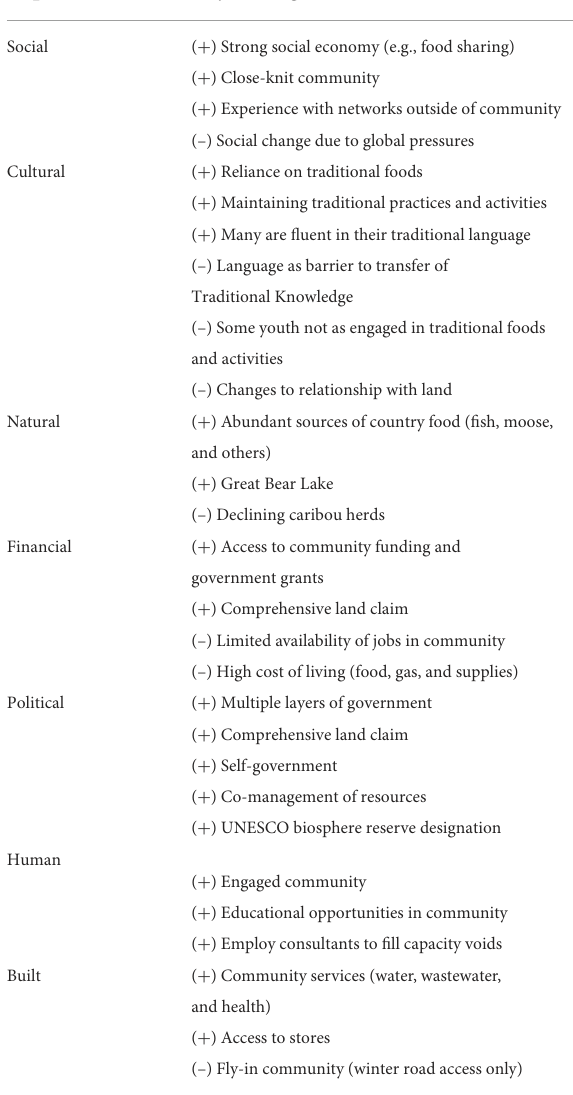
TABLE 1 Summary of the community’s food system based on capitals, and how key findings, as identified through interviews and background research, either add to ( + ) or deplete (–) these